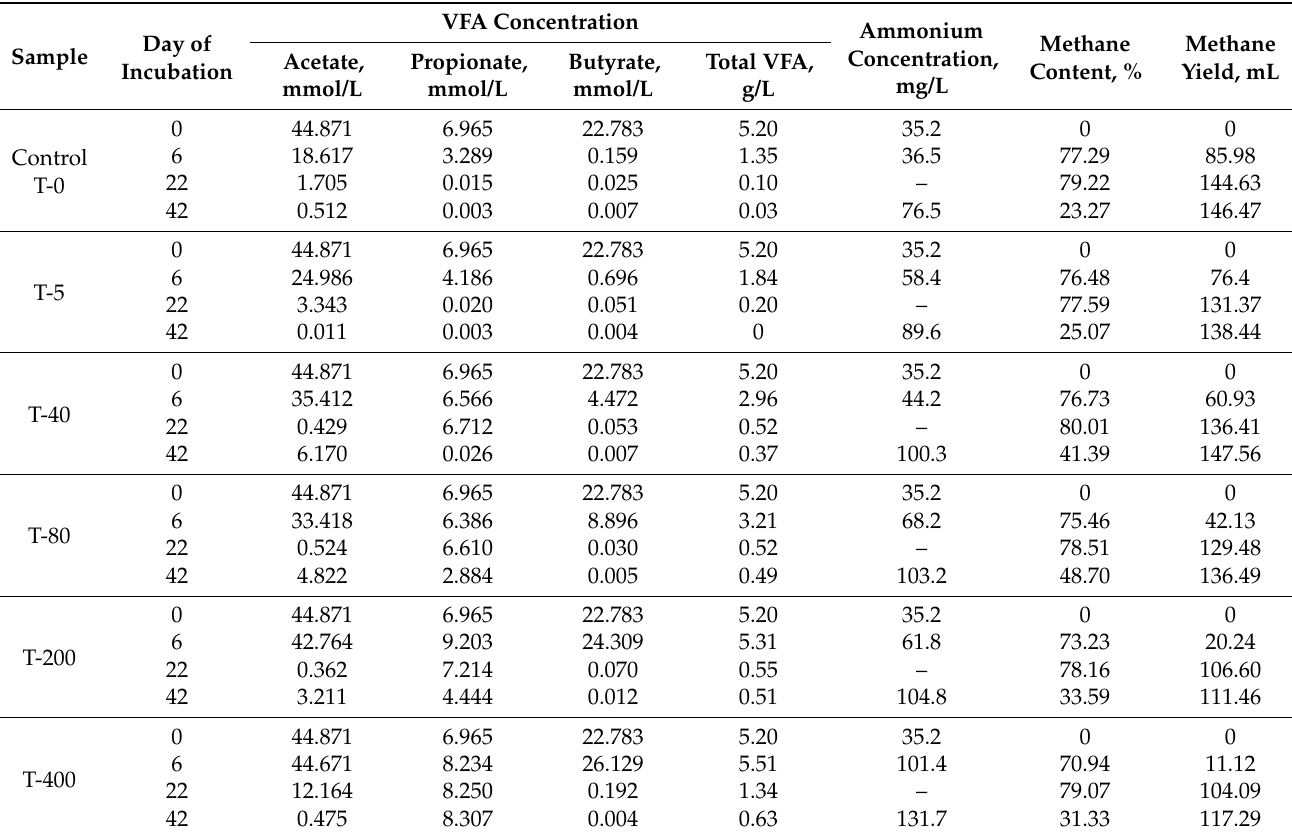
Table 1. Characteristics of the process in the course of batch incubation of digested sludge with different concentrations of